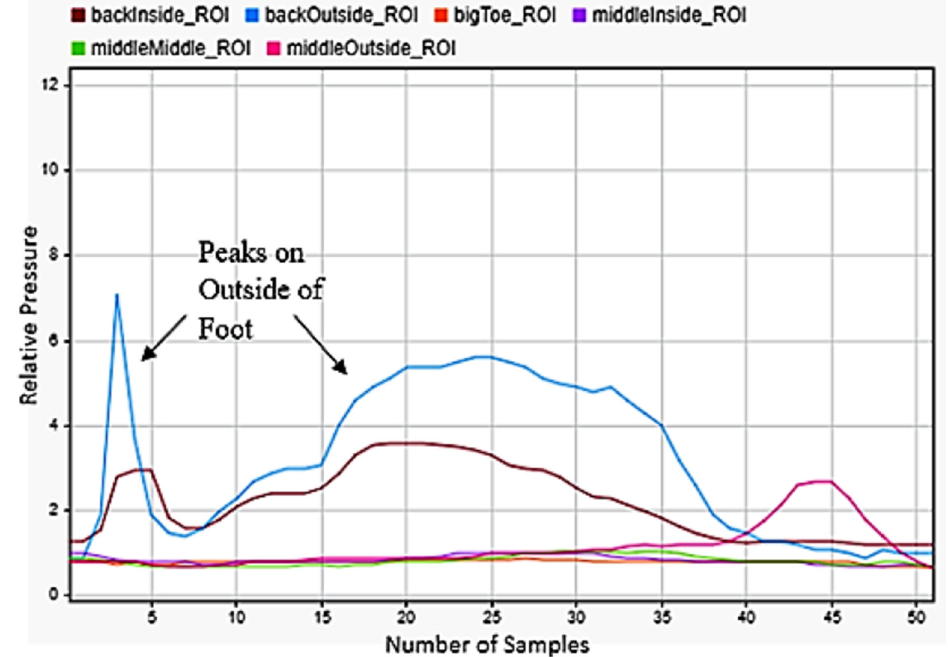
Sensors 2022 , 22 , x FOR PEER REVIEW Figure 15. Falling to the left sensor data for the left. Figure 15. Falling to the left sensor data for the left.